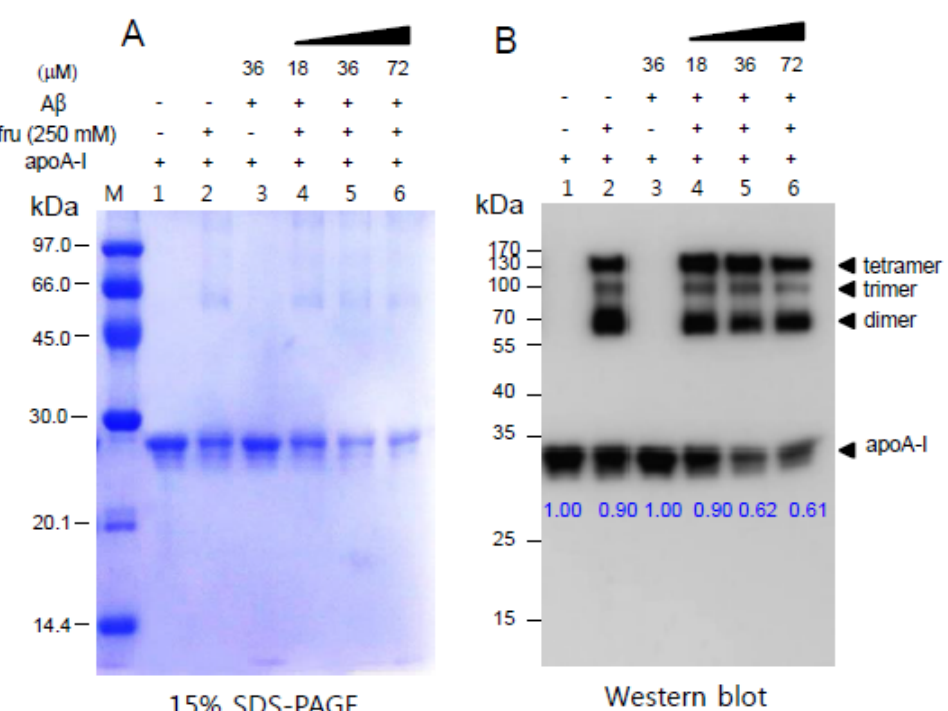
Figure 5. Degradation of apoA-I in the lipid-free state by a treatment with A β in the presence of fructose as visualized by Coomassie Brilliant Blue staining ( A ) and immunodetection with apoA-I antibody ( B ). Blue numbers below apoA-I band indicate a band size of apoA-I monomer in each lane from image analysis.